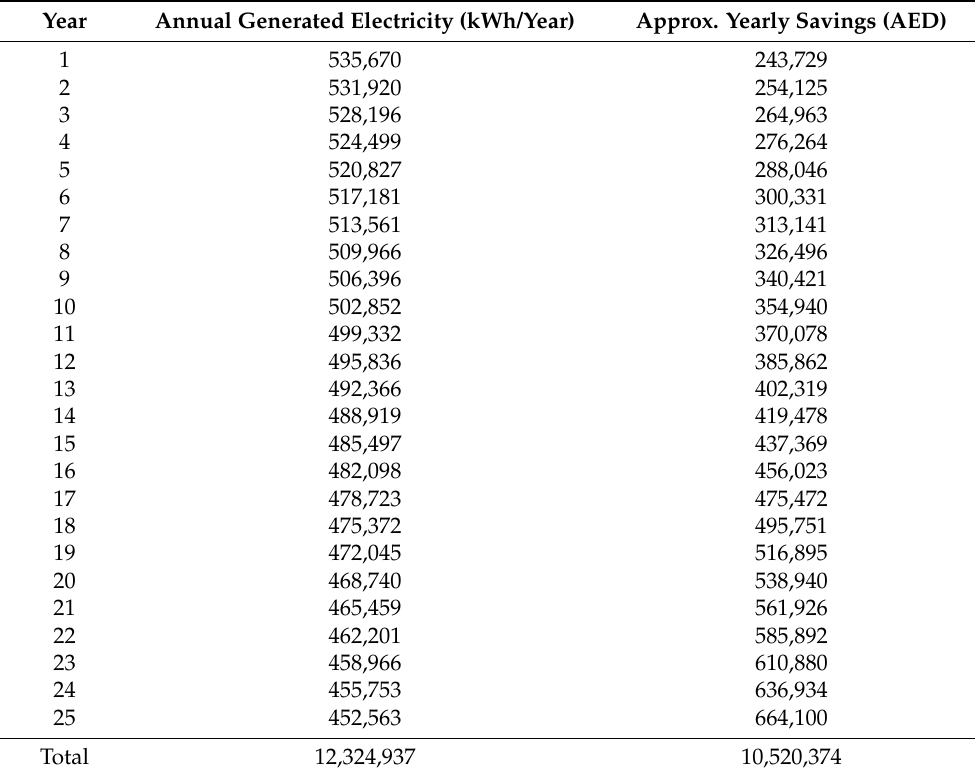
Table 6. Annal generation and savings for the selected PV